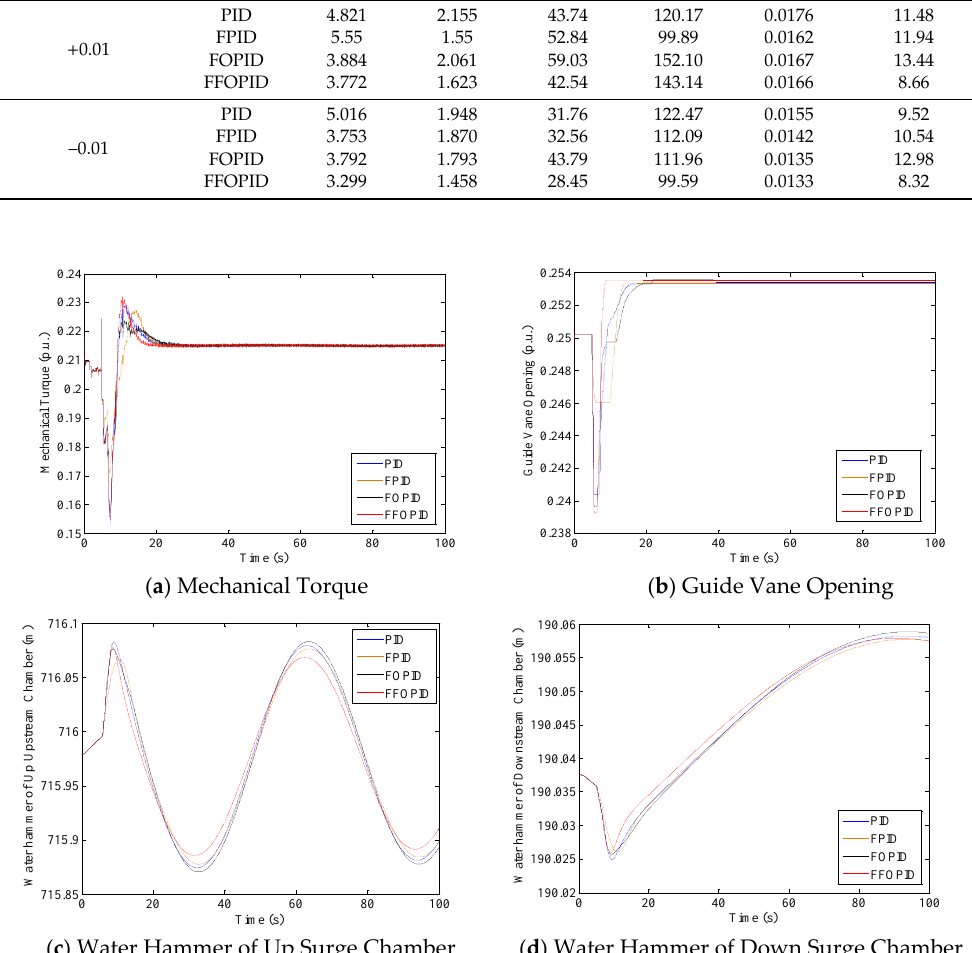
Figure 12. Transient processes of the pumped storage unit (PSU) with different controllers: ( a ) Mechanical Torque; ( b ) Guide Vane Opening; ( c ) Water Hammer of Up Surge Chamber; ( d ) Water Hammer of Down Surge Chamber.